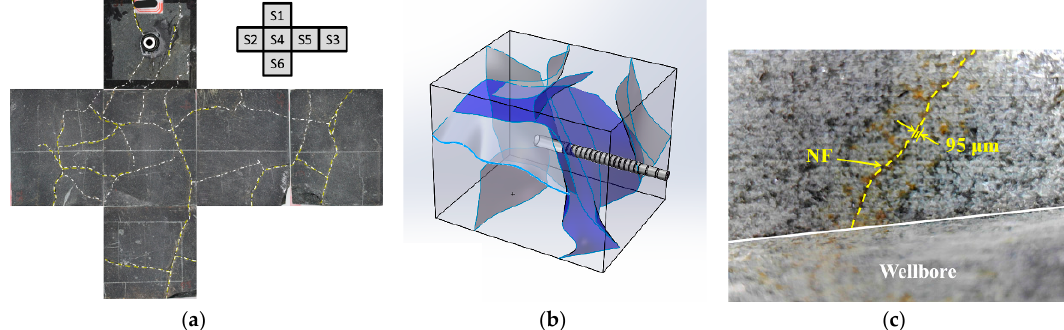
Figure 10. Fracture details of No. 1 specimen: ( a ) Distribution on the surface, ( b ) internal reconstruction, and ( c ) microscopy image. Energies 2020 , 13 , x FOR PEER REVIEW